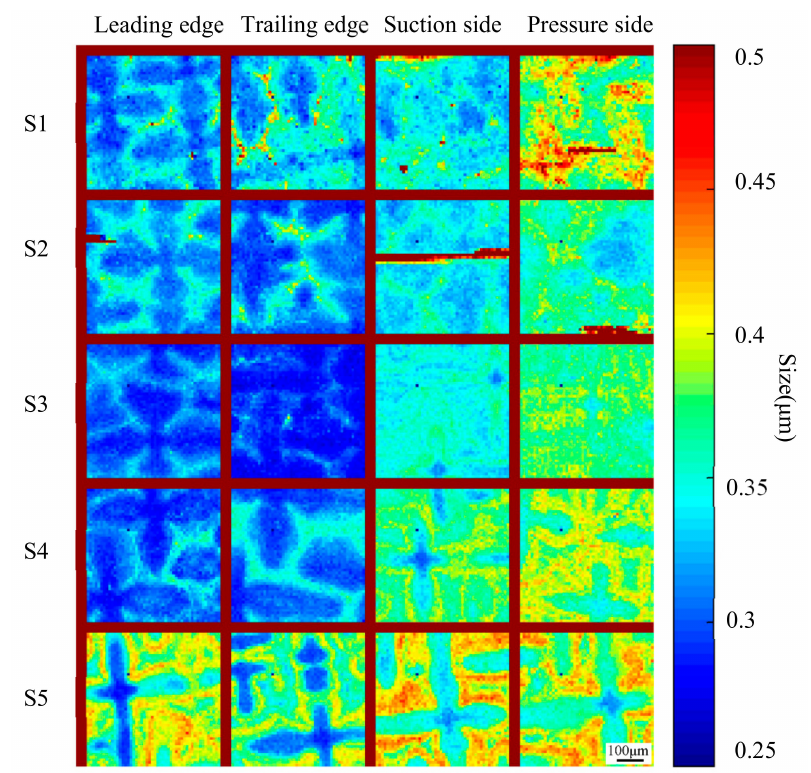
Figure 14. The size distribution of the γ ’ microstructure at the leading edge, trailing edge, suction side and pressure side in the section S1–S5 of the single crystal blade.